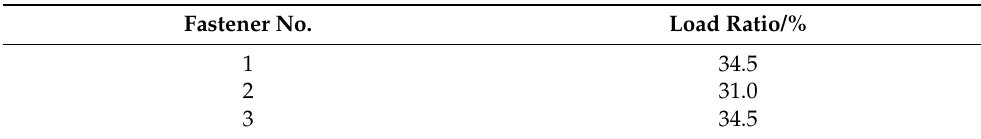
Table 4. The pin-load distribution ratios of three-row fasteners from the analytical method. Fastener No.